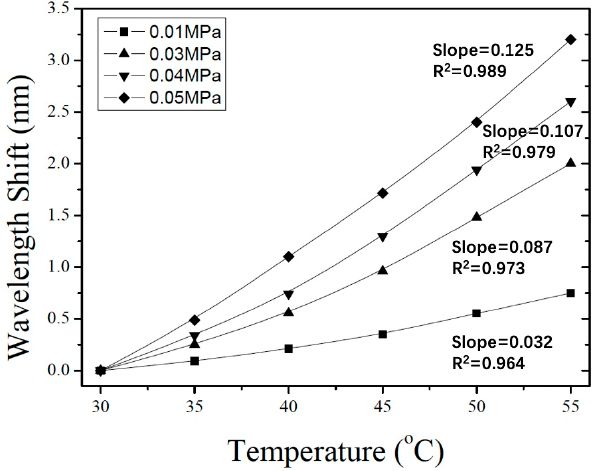
Figure 8. Simulation of temperature sensitivity of sensor for different intracavity pressures.